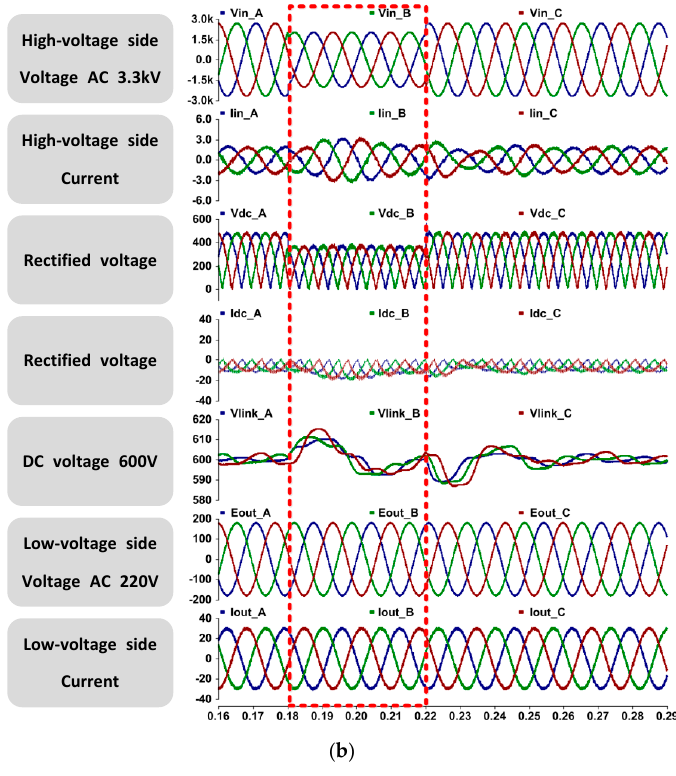
Figure 9. Simulation results in input voltage sag: ( a ) forward power flow; ( b ) reverse power flow.